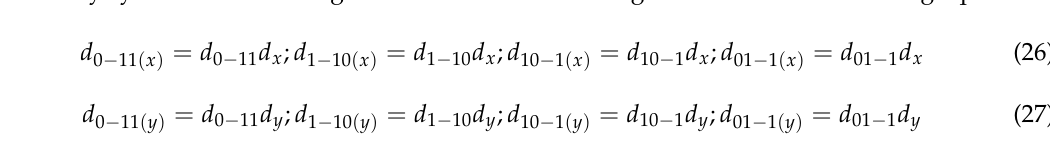
Table 6. The parameter for simulation and